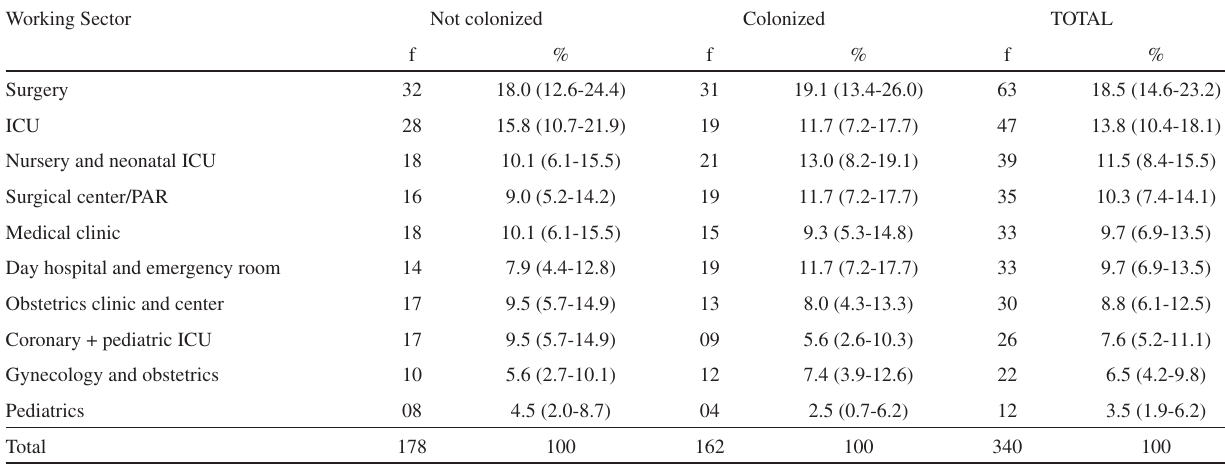
Table 2 - Distribution of participants according to working sector and colonization by S. aureus, 2007-2008 Working